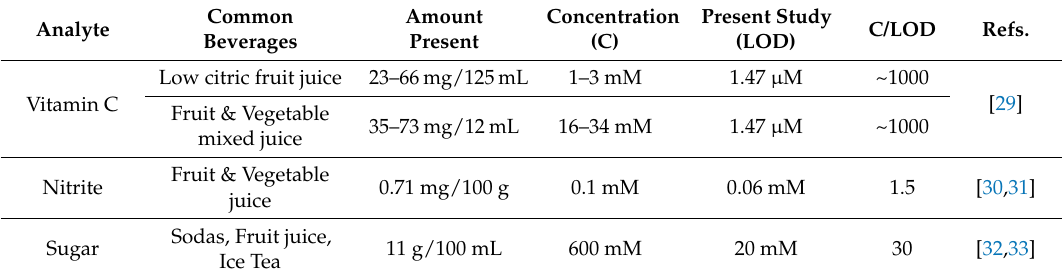
Table 1. Summary of the concentration of common analytes present in beverages.